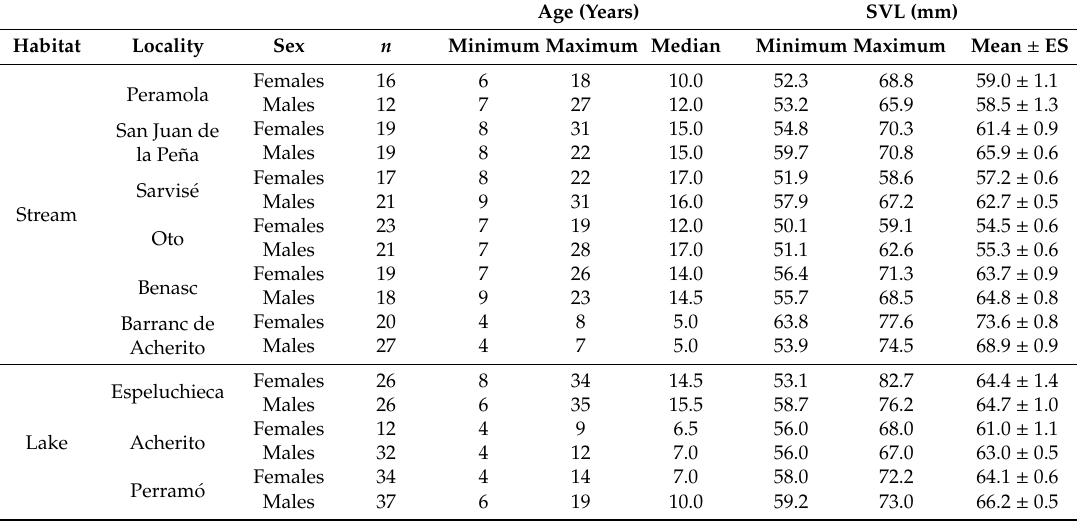
Figure 2. Box-plot of the age structure of the newts for each locality and sex. The 1st Quartile (values up to the first 25% of sample) lower box limit and the 3rd Quartile (values up to 75% of sample) upper box limit. Vertical stripes outside the box identify the maximum and minimum values. The extreme cases are represented by circles. Table 2. Descriptive statistics for age and snout-vent length (SVL) for each sex, locality, and habitat, ES: standard error.